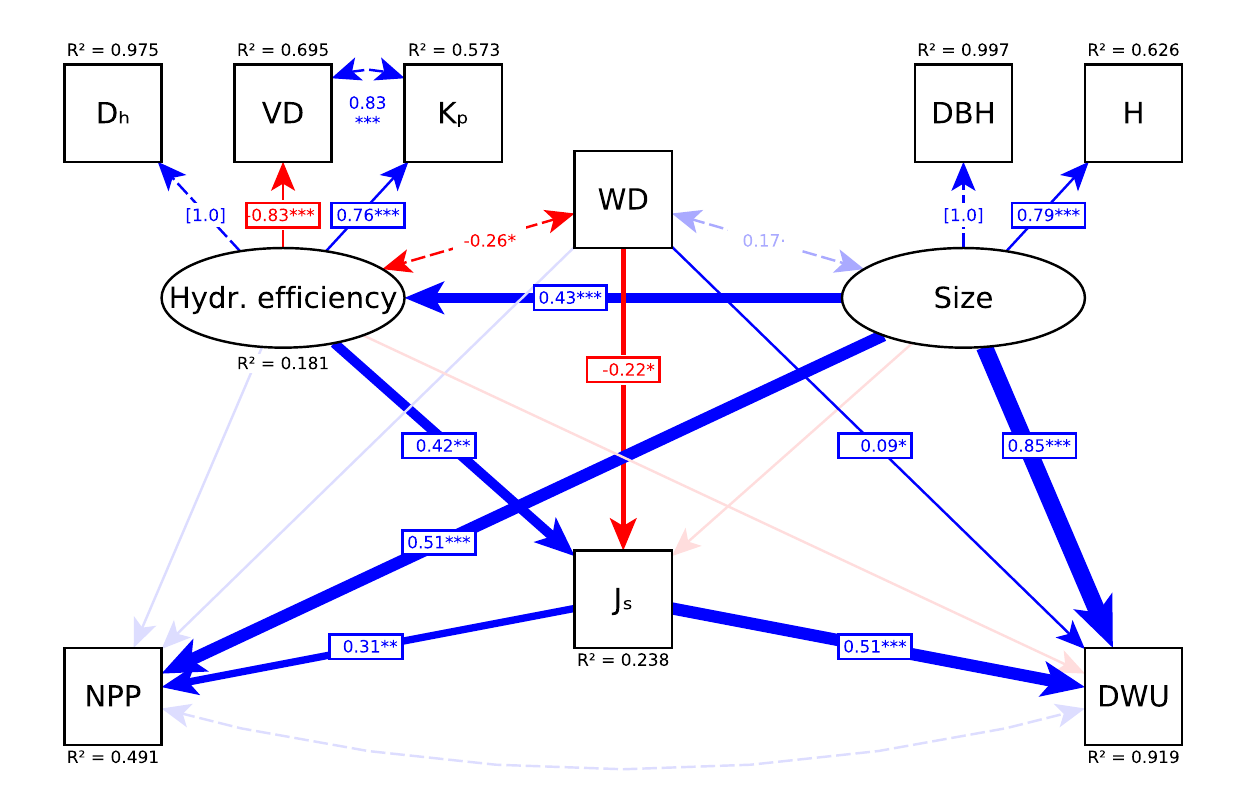
FIGURE 5 | Path diagram of the final model (model χ ² = 15.39, d f = 15, P = 0.442; CFI = 0.999, RMSEA = 0.016). Shown are causal relationships with scaled path coefficients (one-sided arrows), residual correlations (two-sided dashed arrows), and explained variances * P < 0.05, ** P < 0.01, and *** P < 0.001. Positive links are displayed in blue, negative links in red and insignificant links in transparent color. Paths with coefficients fixed to one for computational reasons ( D h and DBH ) are displayed as dashed arrows. See Table 1 for